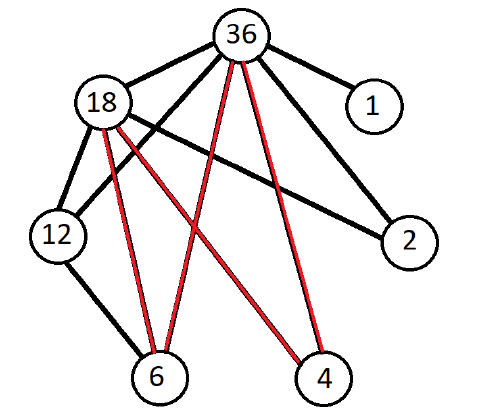
Figure 11. Complete bipartite subgraph on (4, 6) and (18,